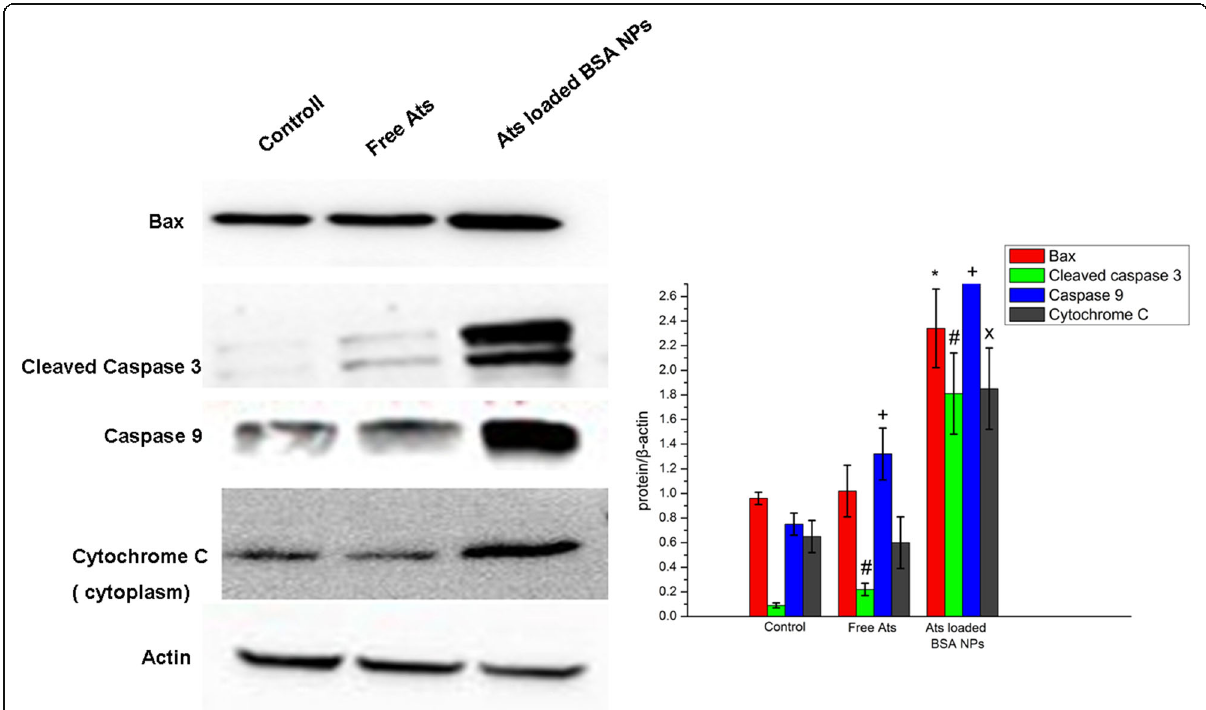
Fig. 6 Western blot analyses of the expression levels of cleaved caspase-3, caspase-9, Bax, and cytochrome C in SMMC-7721 cells. * P < 0.05 versus the Bax protein expression of the control group; # P <0.05 versus the cleaved caspase-3 expression of the control group; + P <0.05 versus the caspase-9 protein expression of the control group; x P < 0.05 versus the cytochrome C protein expression of the control group. Data were presented as the mean ± SD ( n =